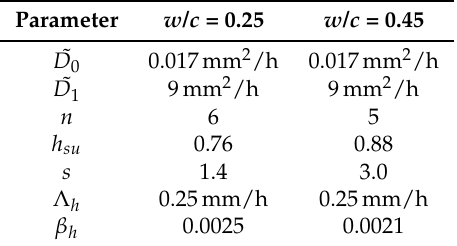
Table 3. Parameter settings for simulations of autogenous and drying shrinkage.